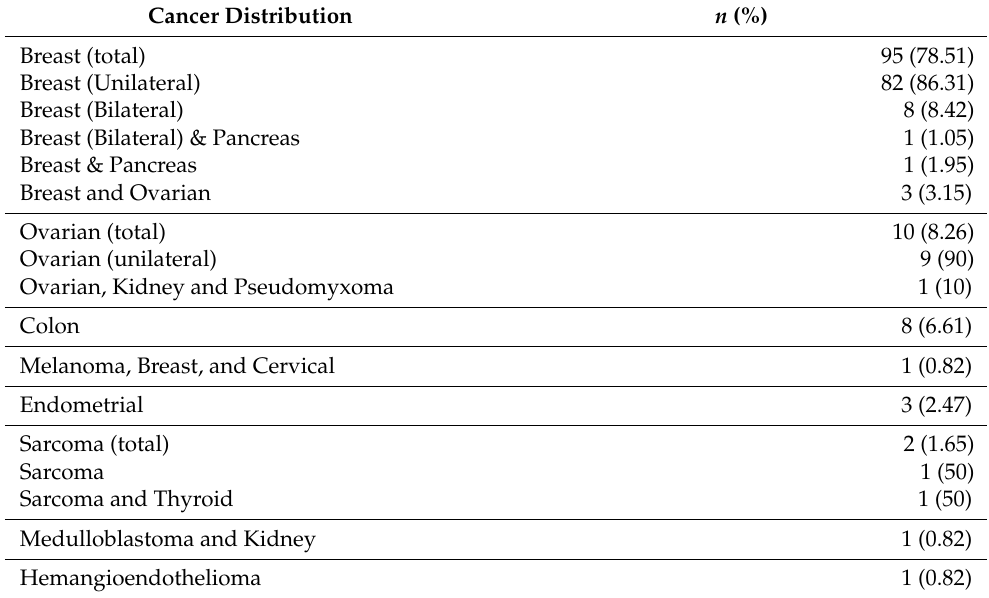
Table 1. Cancer distribution: A total of 121 cancer patients were distributed by